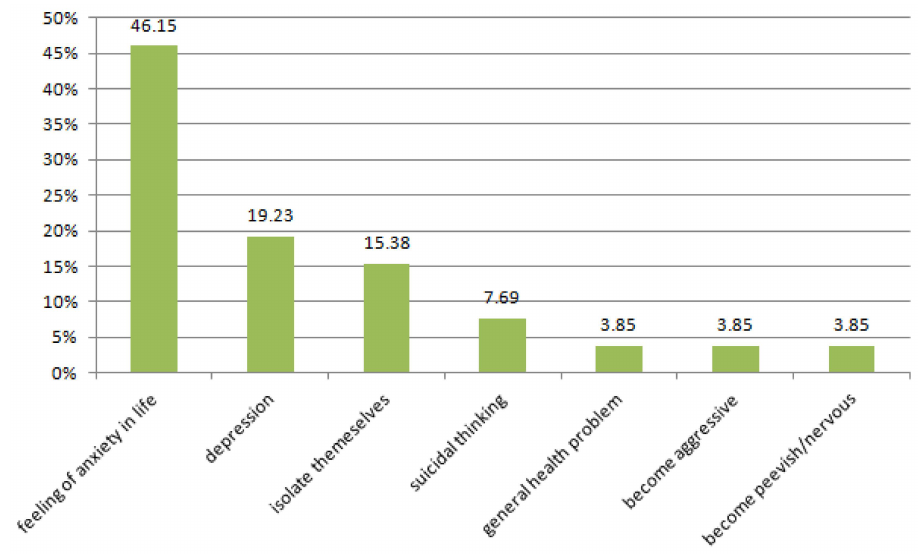
Figure 3. How stress negatively influences your life.